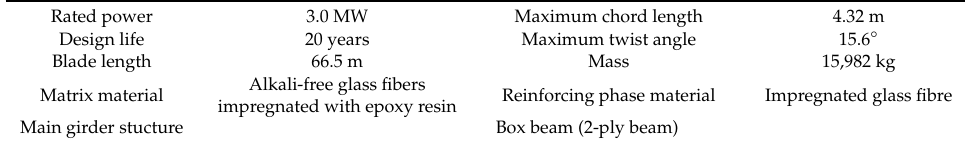
Table 1. The main information of the turbine